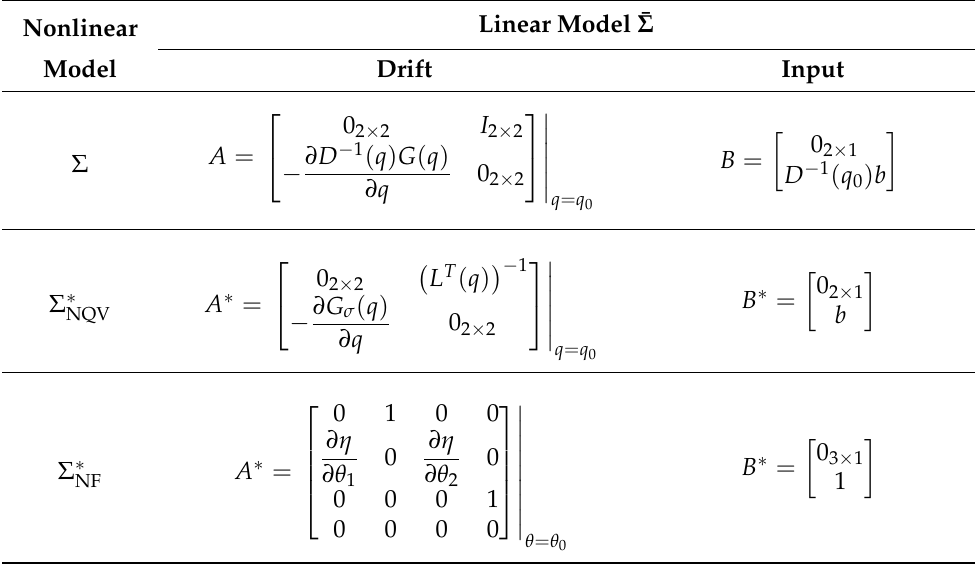
Table 1. Local transformation matrices: Σ ∗